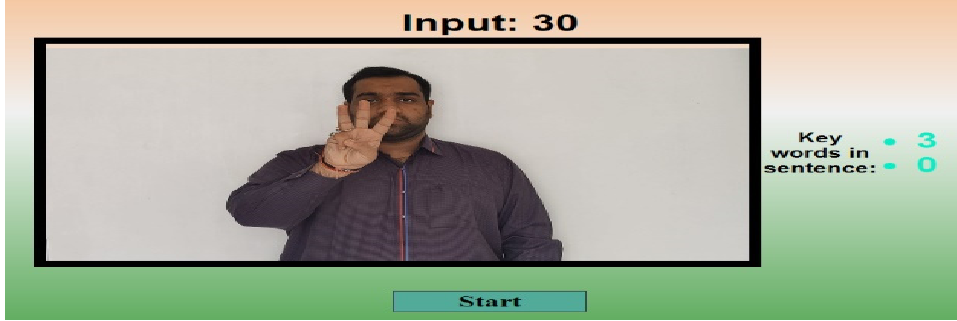
Figure 17. Case 8. Available video for number ‘3’.